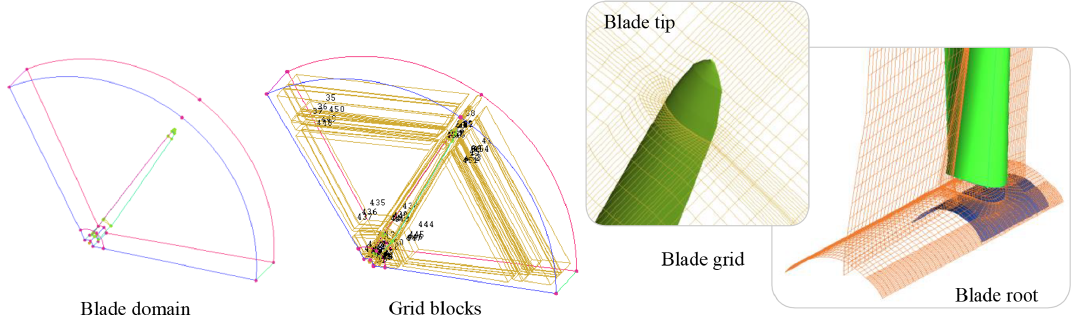
Figure 3. Blade computational grid.